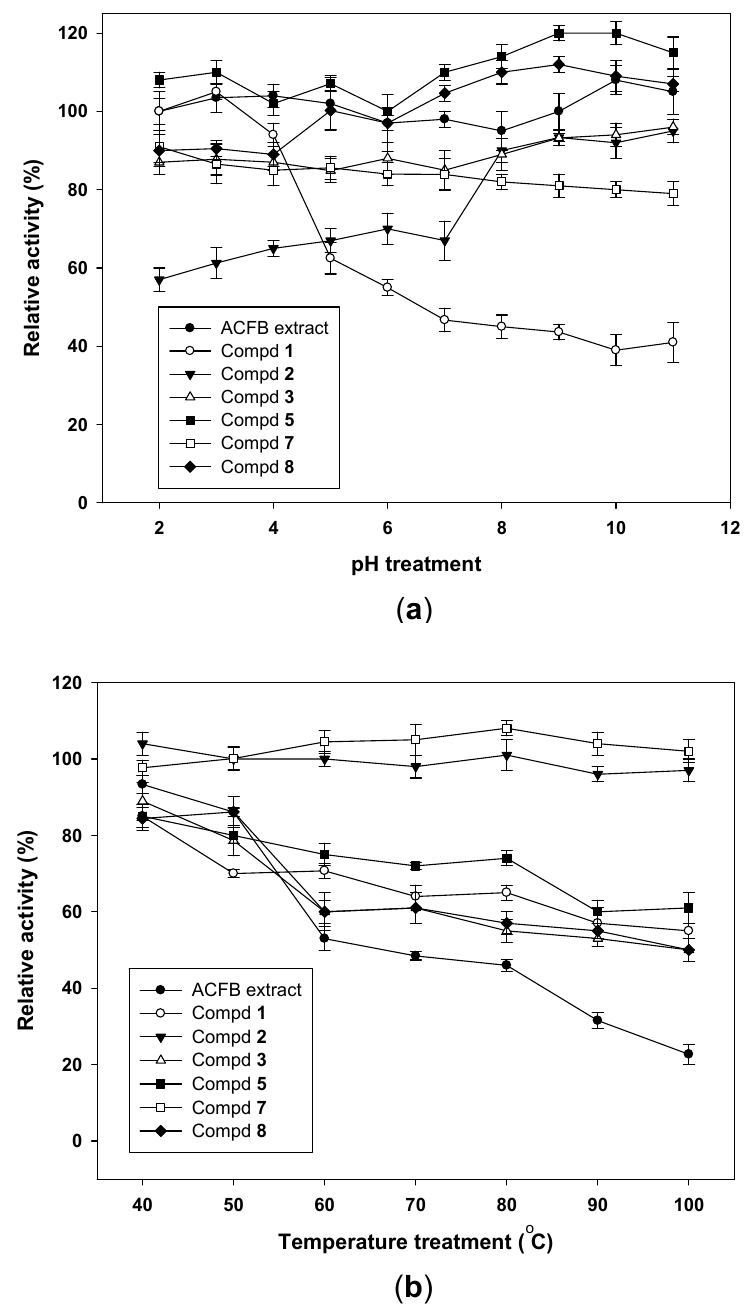
Figure 4. The pH and thermal stabilities of ACFB extract and the purified compounds. The pH ( a ) and thermal ( b ) stability of ACFB and its purified compounds were tested by treating the samples with a range of pH (2–11) and temperatures (40–100 °C) for 30 min, respectively. The α -glucosidase inhibition of treated samples was tested under the same conditions, using the bioassay mentioned in the methods section. Tests were performed in triplicate. Results are means ± SD.